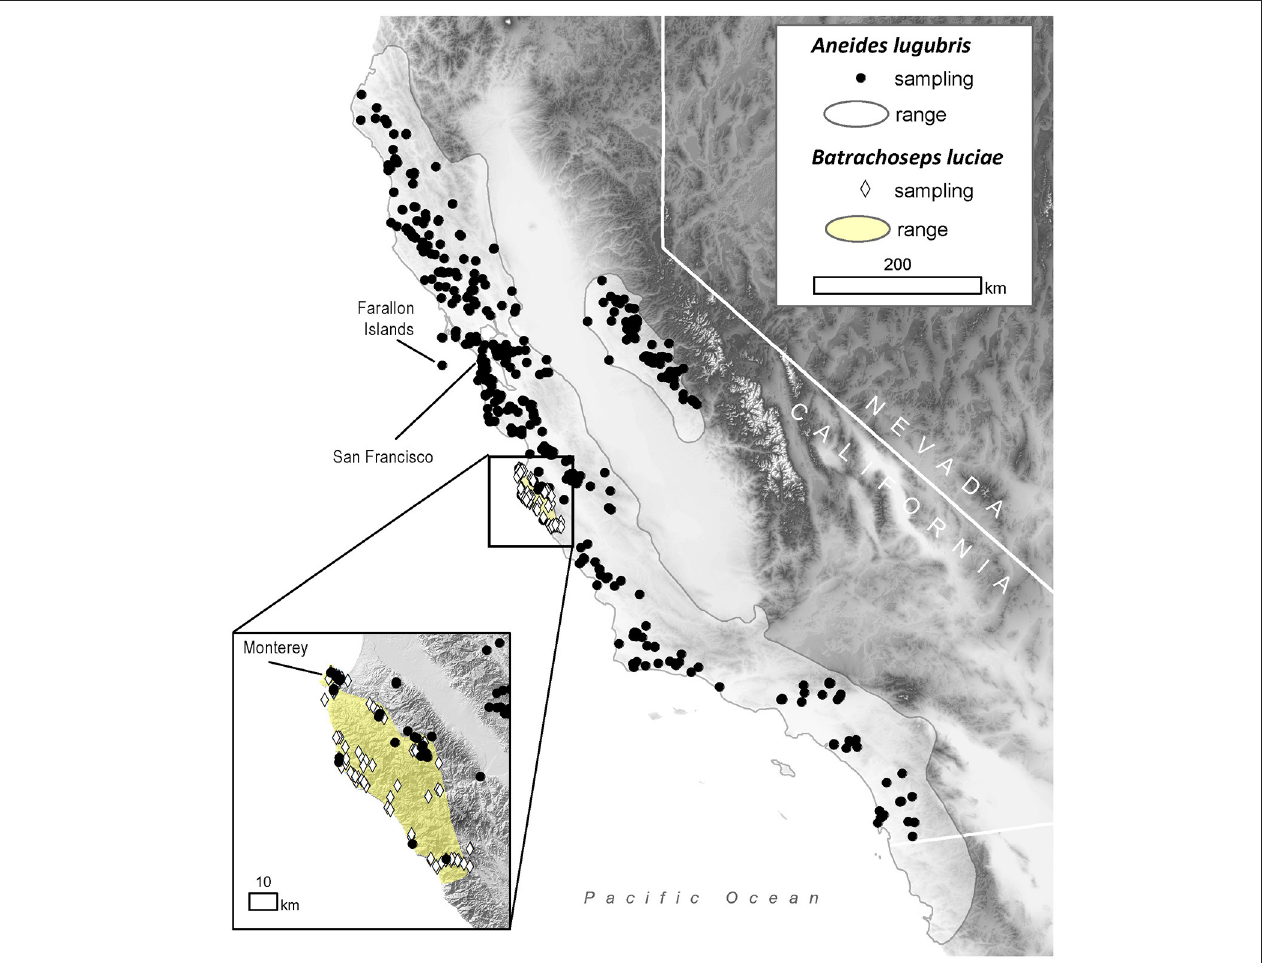
FIGURE 1 | Distribution of sampling locations within the range of the arboreal salamander ( Aneides lugubris ; solid gray line) and the Santa Lucia Mountains slender salamander ( Batrachoseps luciae ; yellow area) in California,